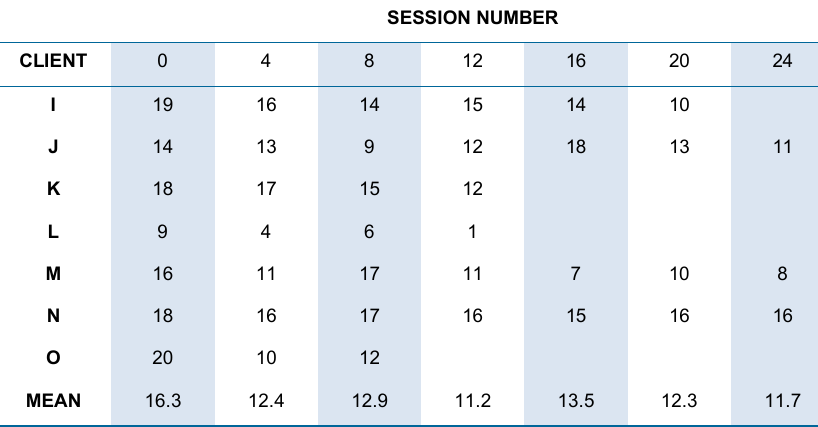
Table 9: Mean GAD-7 score: 7 short-term